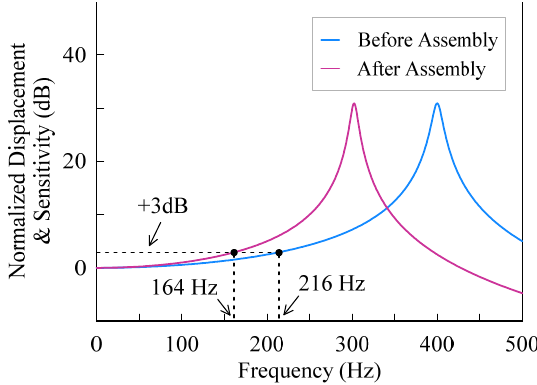
Figure 12. Frequency response of the accelerometer.